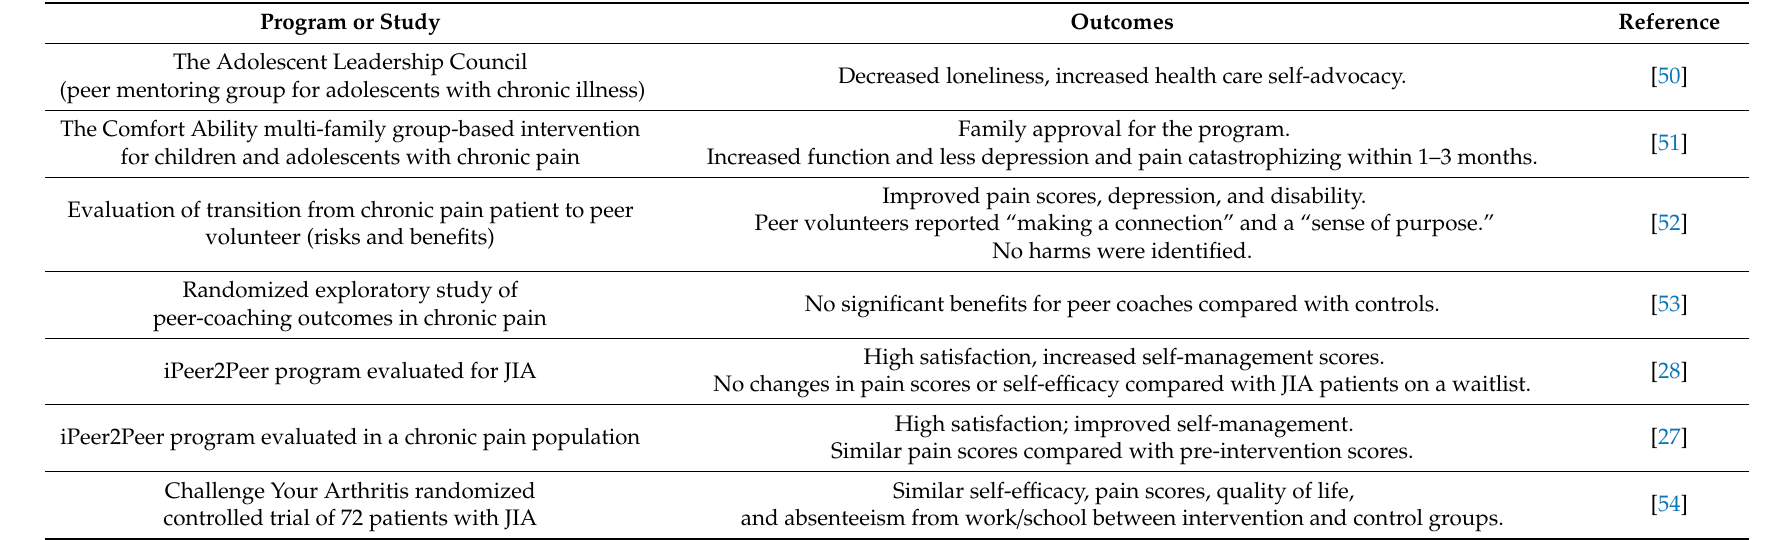
Table 2. Outcomes research for peer support programs for adolescents with chronic